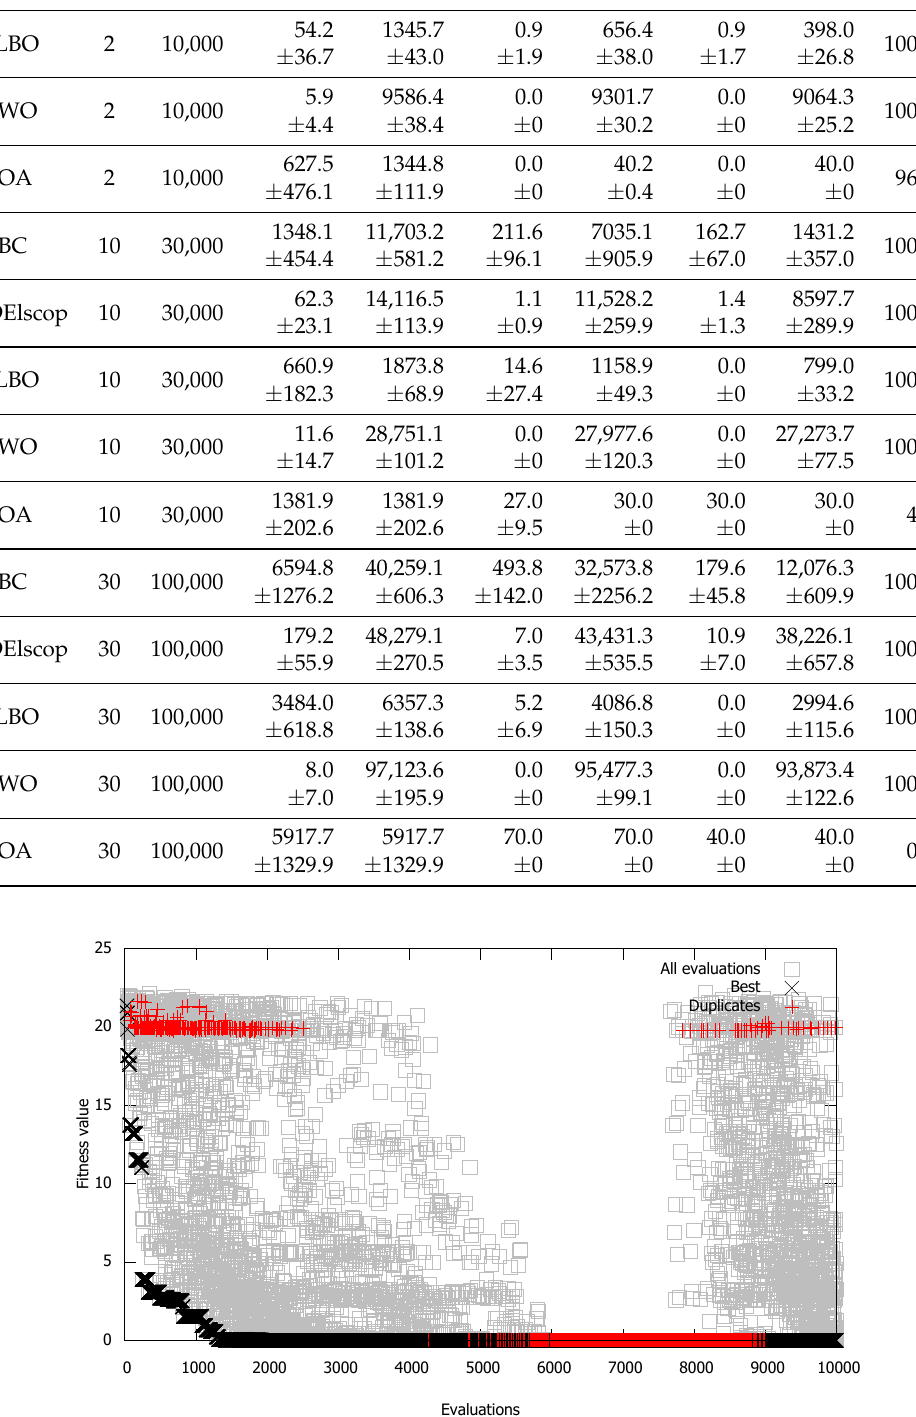
Figure 6. One run of the ABC algorithm on the Ackley problem for n = 2 and Pr =